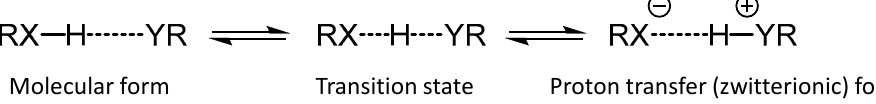
Figure 2. Transition from the molecular form to the proton transfer (zwitterionic) form of the hydrogen-bonded complex.